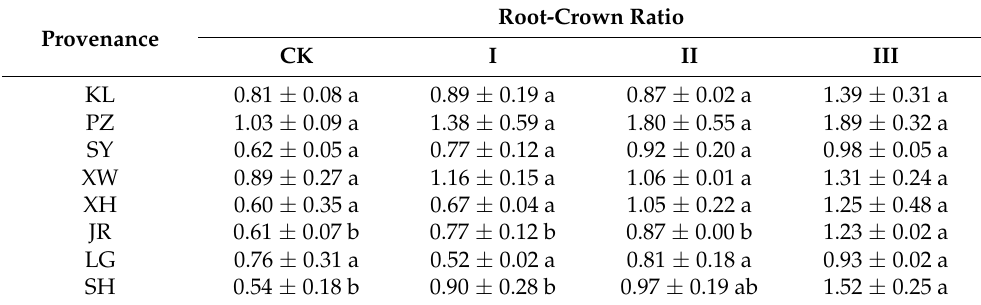
Table 5. The root–shoot ratio of the Melia azedarach seedlings among different provenances under drought